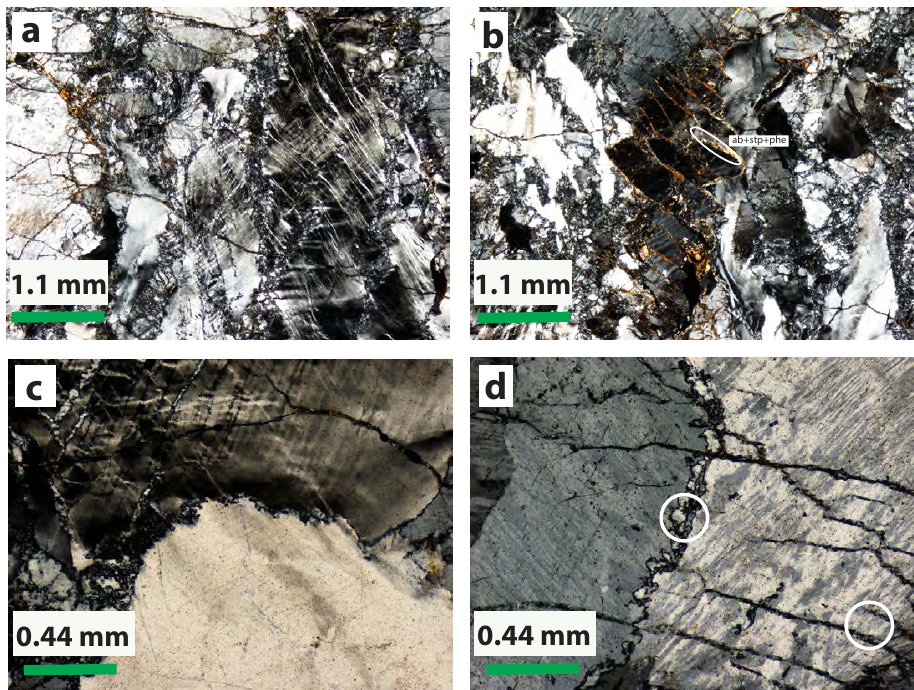
Figure 3. Microphotographs of host-protomylonite showing quartz microstructures typical of low-temperature plasticity: (a) intracrystalline deformation (undulatory extinction, deformation lamellae, deformation bands, localized extinction bands, LEBs) associated with recrystal- lization along intragranular conjugate shear bands sets; (b) domino-style brittle fracturing of K-feldspar and associated K-feldspar breakdown to albite, stilpnomelane, and phengite; (c) quartz deformation lamellae and intergranular recrystallization by bulging; and (d) K-feldspar inter- granular recrystallization and albite neocrystallization and recrystallization also observable along later cracks and microfractures (horizontal to